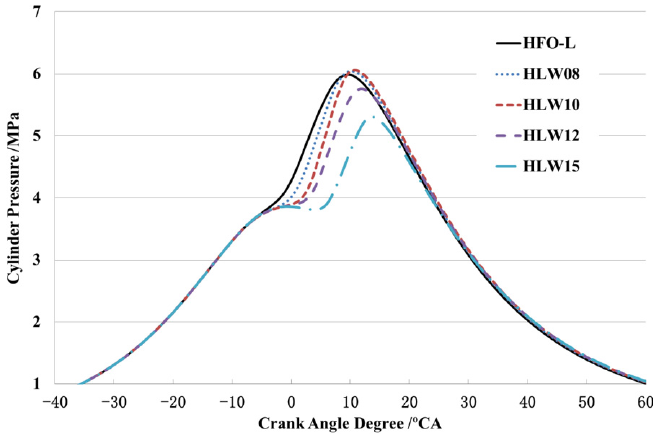
Figure 9. The comparison of cylinder pressure curves of the cases of fueling with five fuel blends. The increase of ignition delay is basically due to the lower gas temperature caused by water evaporation. The prolongation of ignition has a great influence on the engine’s performance. Longer ignition delay leads to a shifting of θ pmax and a change of the value of p max . As shown in Figure 9, when the water content is not higher than 10%, the values of p max are higher than that of HFO-L. But for the cases of water content higher than 10%, p max decreases as water content increases further. Figure 10 is the comparison of heat release rate curves. The figure shows that all of the water emulsified fuels have higher heat release rate curve peaks, and HLW10 has the highest peak.